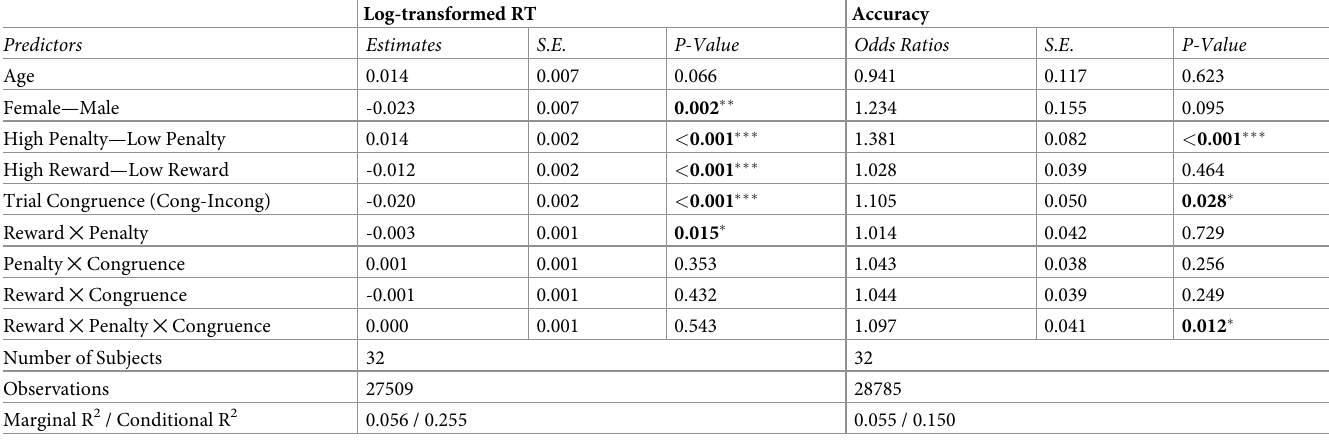
Table 2. Mixed Model Results for Log-Transformed Reaction Time and Accuracy (Study